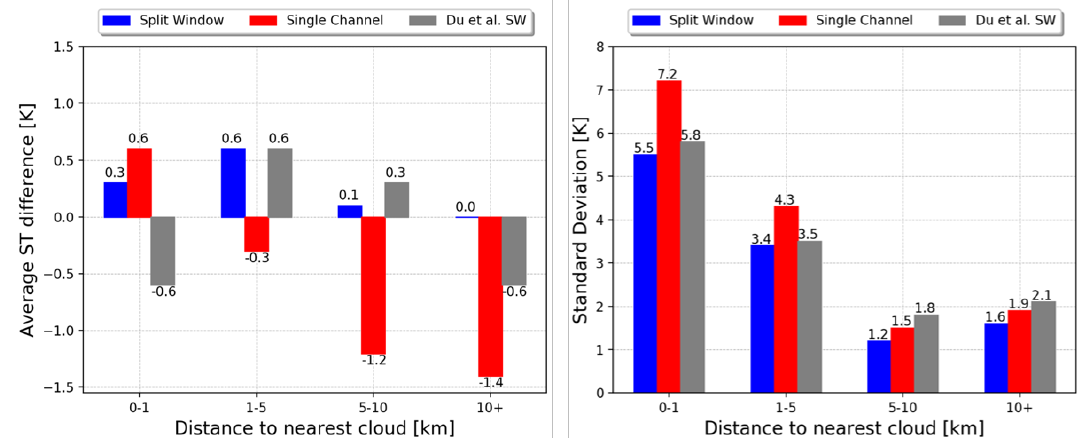
Figure 8. All sites validation: the average differences between the reference temperature measurements and the Landsat-derived surface temperatures for the three retrieval methodologies ( left ) and the corresponding standard deviations of the residuals ( right